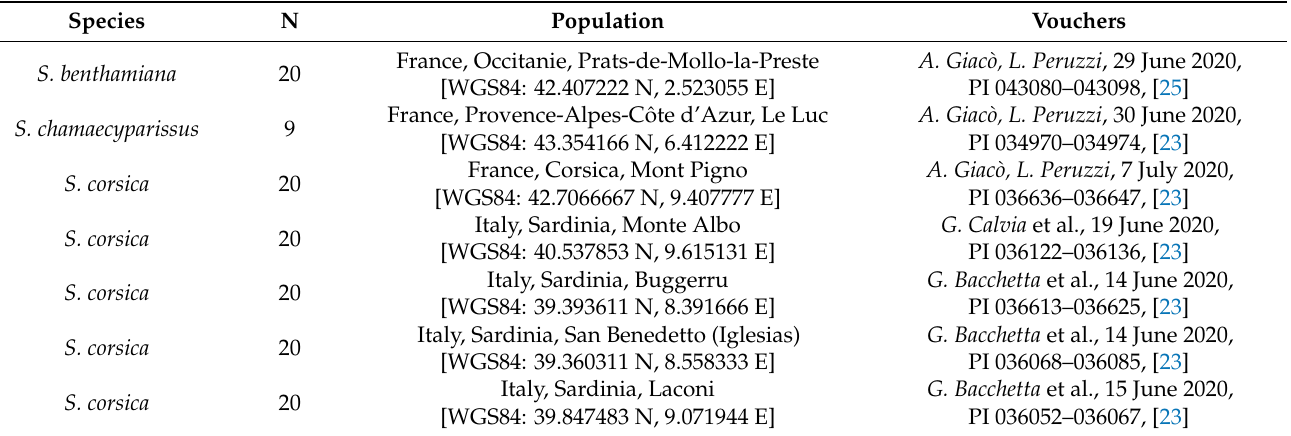
Table 5. The information concerning the populations of the Santolina chamaecyparissus complex analyzed in this